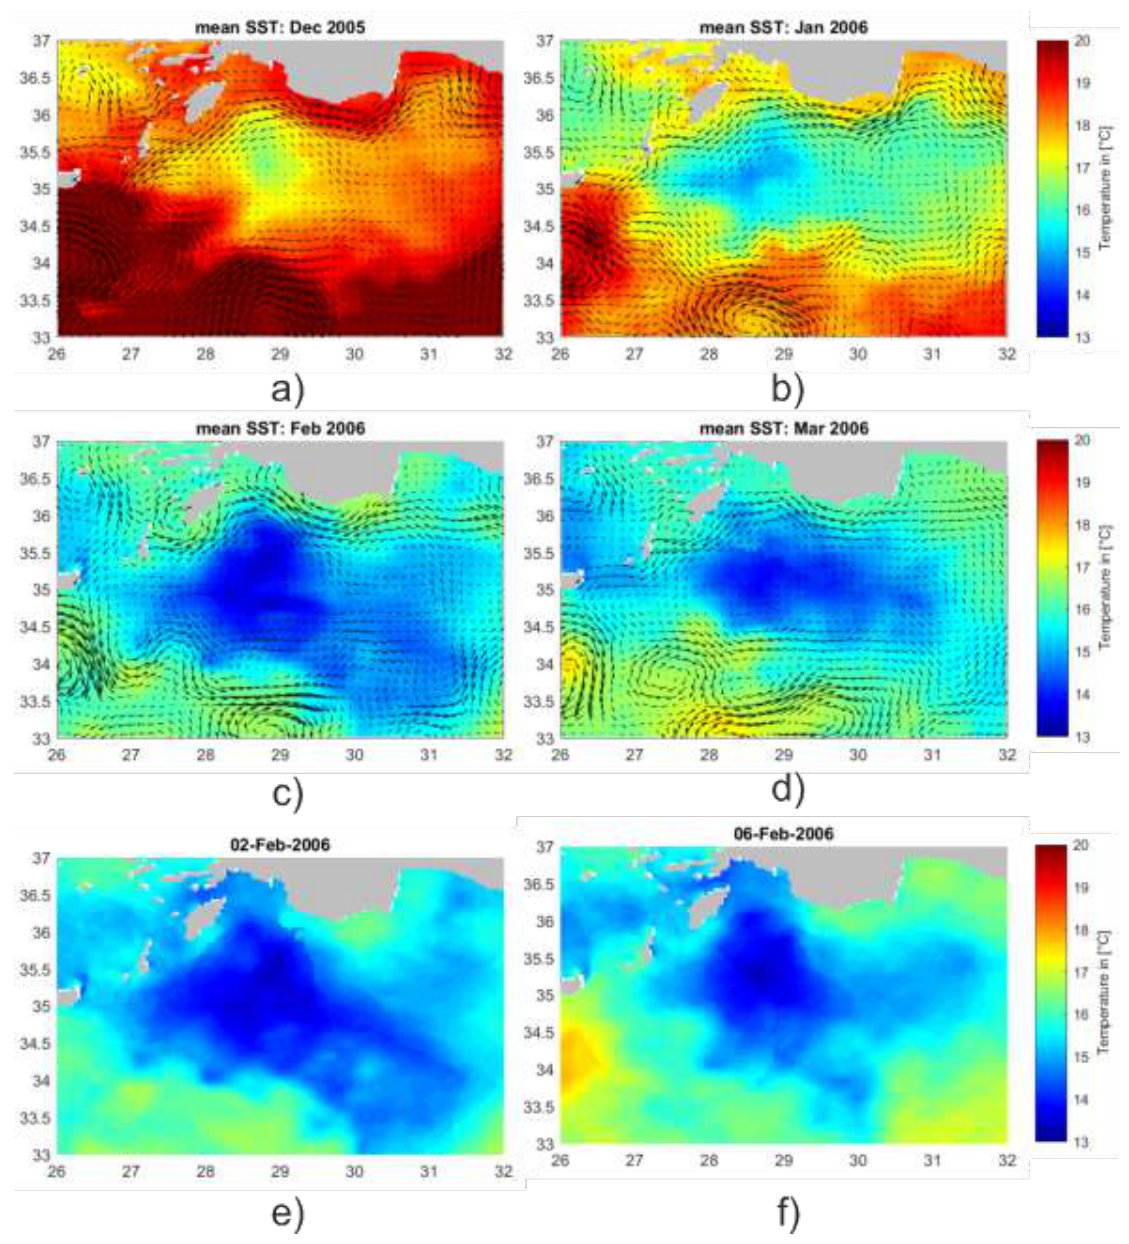
Figure 10. Monthly means of sea surface temperature (SST, °C) and geostrophic currents for ( a ) December 2005, ( b ) January, ( c ) February, and ( d ) March 2006. Daily SST (°C) of ( e ) 2 February 2006 and ( f ) 6 February 2006. Dense water formation and the deep convection event occurred by the end of January until mid-February when SST was